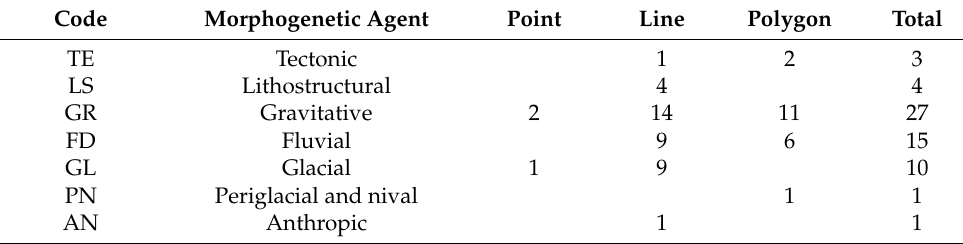
Table 3. Morphogenetic agents and shape